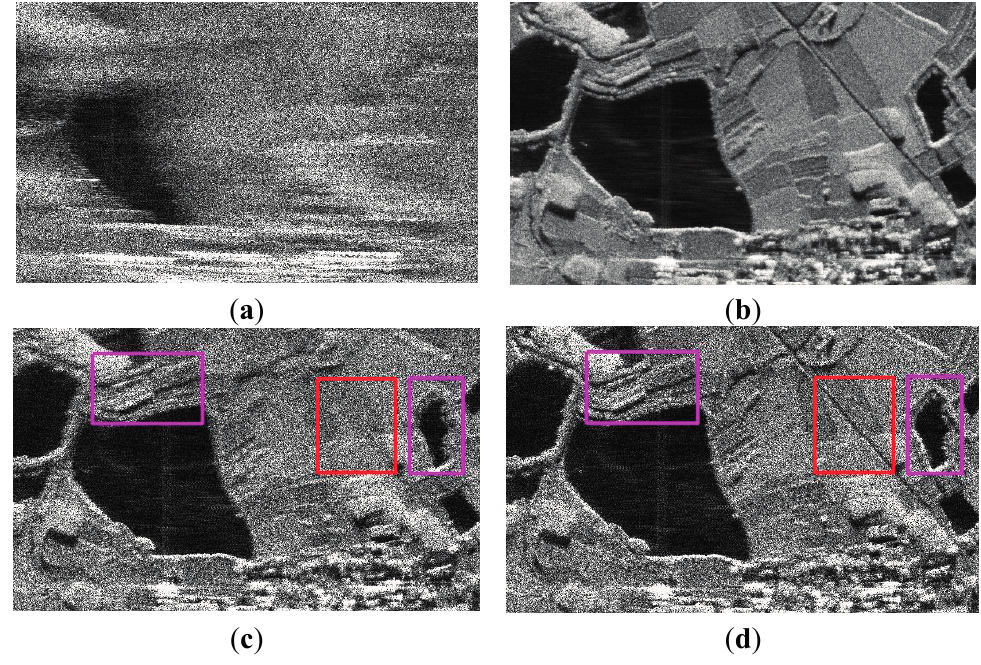
Figure 8. Comparison of the reconstructed images: ( a ) The defocus image; ( b ) RD imaging with motion compensation; ( c ) CS-SAR imaging with motion compensation [18]; and ( d ) ASR-CS-SAR imaging with motion